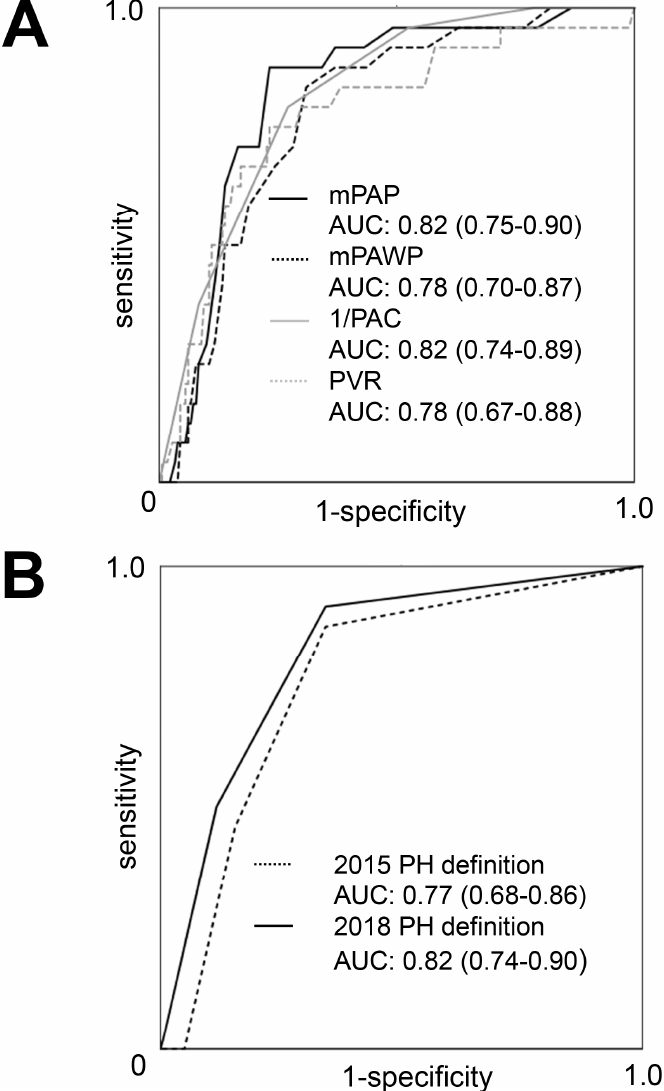
Figure 3. Receiver operator characteristics curves showing areas under the curve (AUC; with 95% confidence intervals) for the prediction of post-AVR PH for mean pulmonary artery pressure (mPAP), mean pulmonary artery wedge pressure (mPAWP), pulmonary artery capacitance (PAC), and pul- monary vascular resistance (PVR; all in panel ( A )) and pulmonary hypertension (PH) according to the 2015 and 2018 definitions (panel ( B )). Post-AVR PH = pulmonary hypertension several months after aortic valve replacement (defined as systolic pulmonary artery pressure > 45 mmHg by echocar-